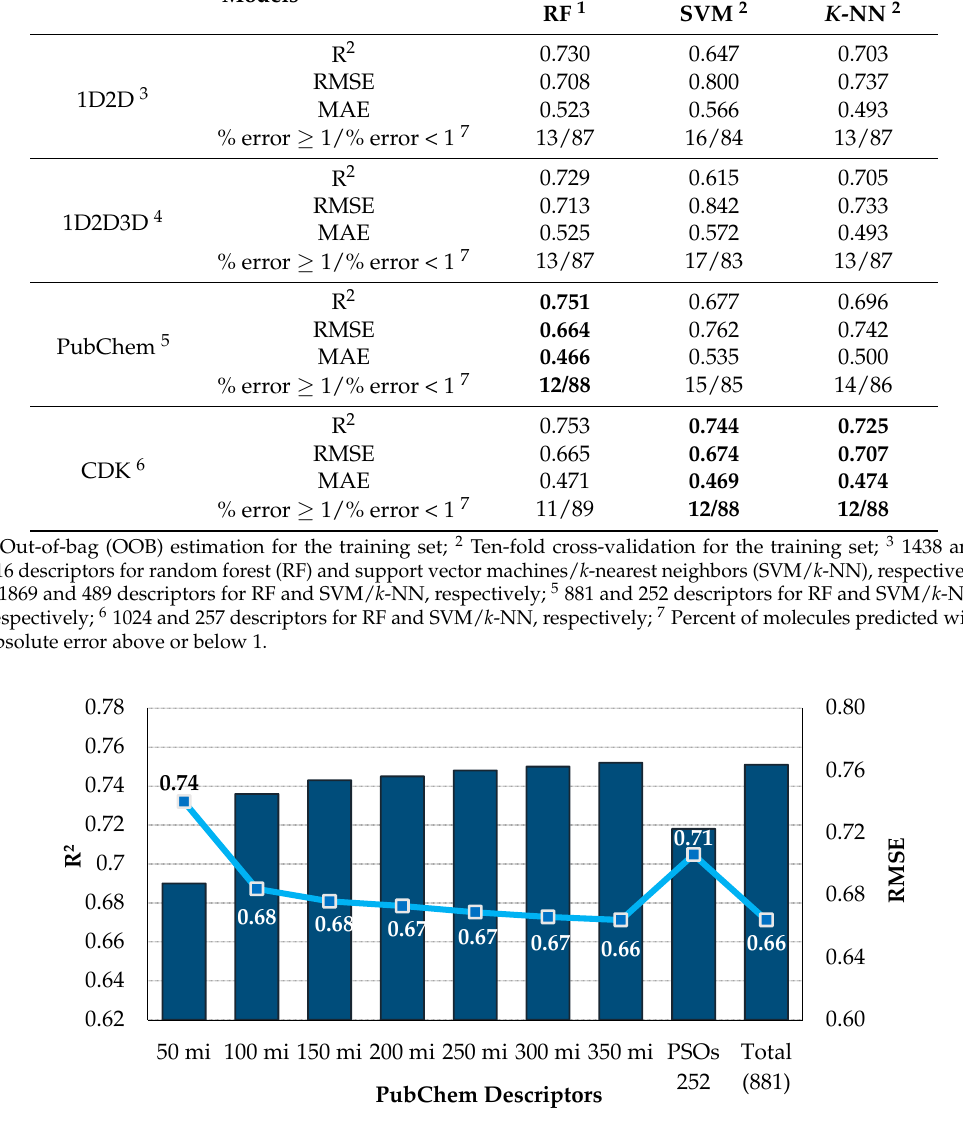
Figure 2. Analysis of Descriptor Selection Using RF algorithm in an OOB estimation for the training set. Table 5. The predictions of the best HCT116 QSAR model by the ten structural clusters for training and test sets. The best models are highlighted in bold.